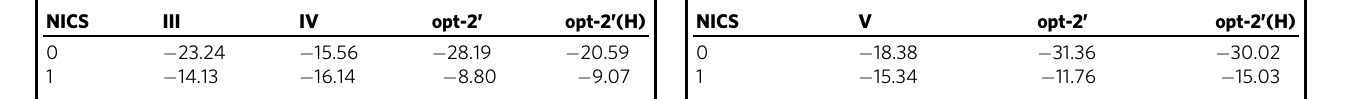
opt-2 ’ , and opt-2 ’ (H) at the B3LYP/6-311G** level of theory. NICS III IV opt-2 ’ opt-2 ’